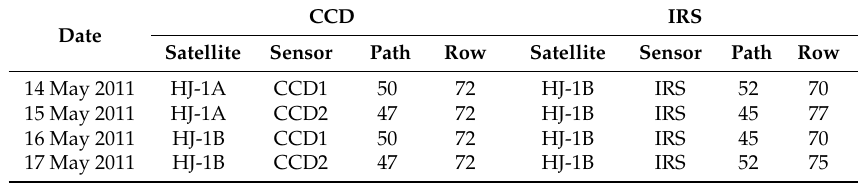
Table 1. Path and row numbers of the referenced HJ-1A/B data acquired on 14–17 May